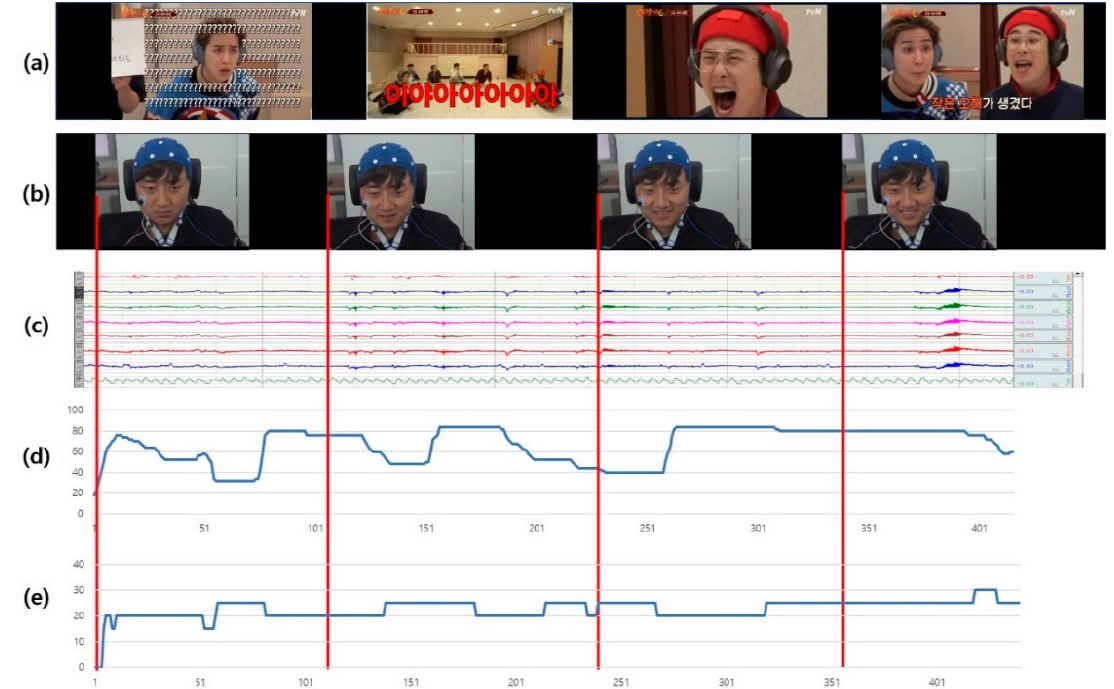
Figure 3. MERTI-Apps data acquisition example, ( a ) video, ( b ) face video, ( c ) bio-signals, ( d ) valence annotation labeling, ( e ) arousal annotation labeling.